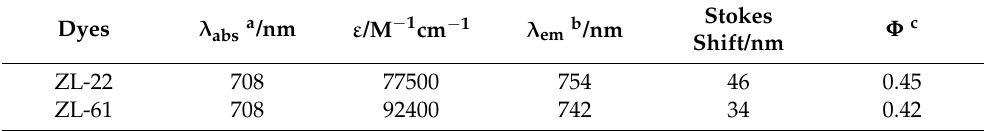
Figure 1. Fluorescence spectra ( A ) and UV-vis absorption spectra ( B ) of the compounds ZL-22 and ZL-61 [14]. Table 1. Absorption spectrum properties of experimental dyes [14].